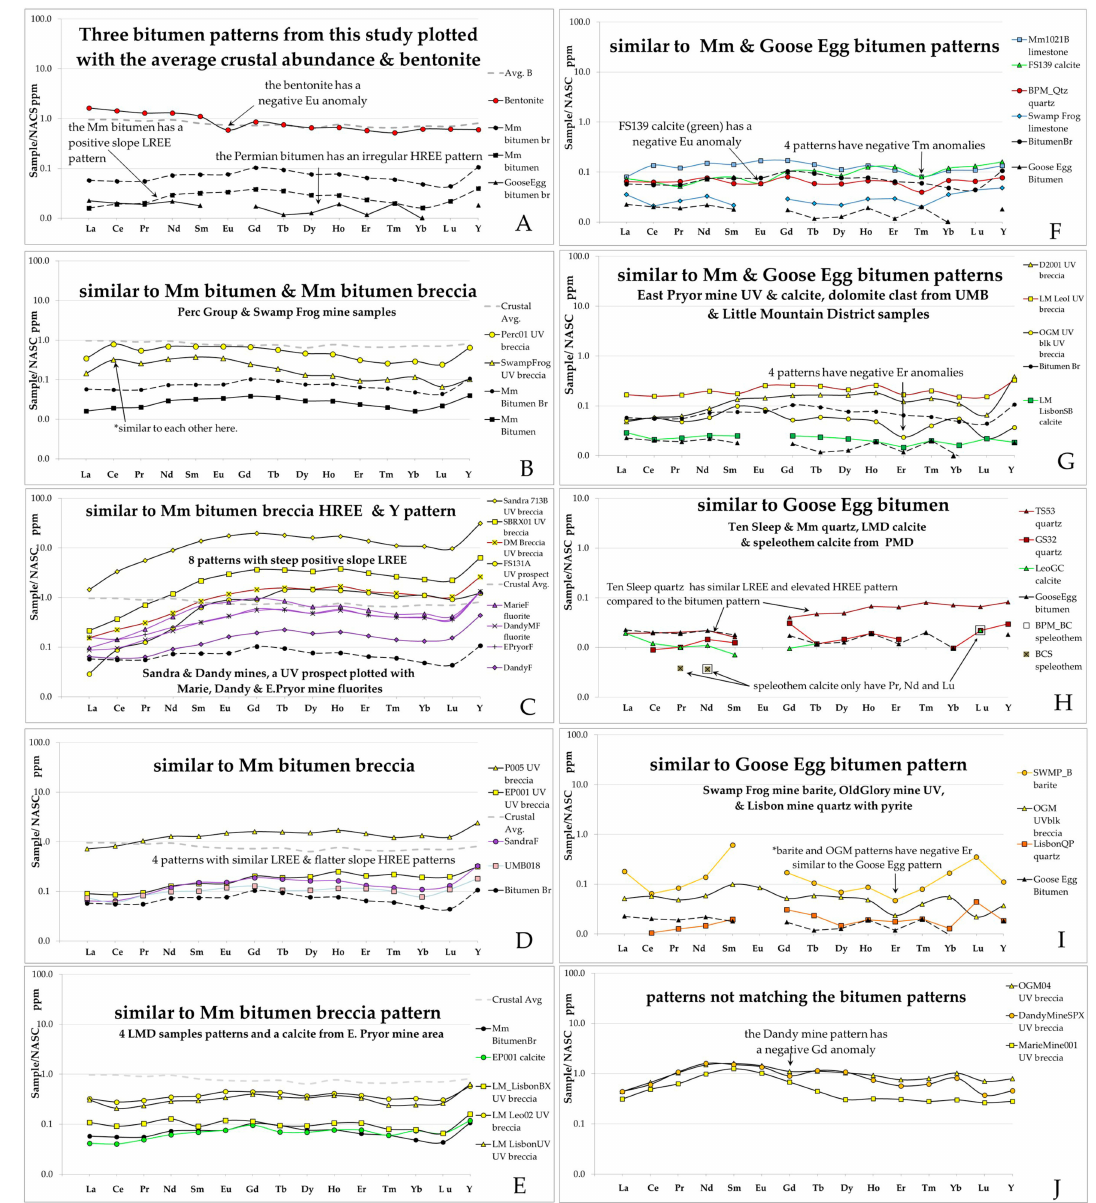
Figure 9. Spidergram plots of REE plus Y data from (North American Shale Composite) NASC-normalized samples. Each graph ( A – J ) is plotted using a log base 10 scale (range is 0.01 ppm–100 ppm). Plots are split up by similar REE and Y patterns. The bitumen data are plotted in Figure 9A with the bentonite and the average crustal abundance. Many of the mineralized and gangue minerals resemble portions of the bitumen patterns. Those patterns that are similar to the bitumen are plotted with bitumen ( B – I ). Mississippian Madison Group is abbreviated Mm in the